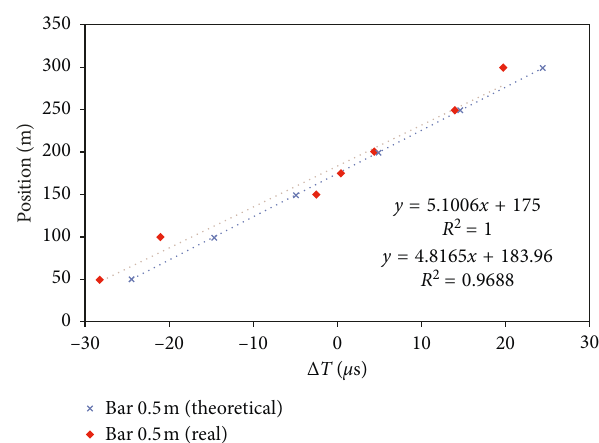
Figure 6: Time delay for different impacts; steel bar of